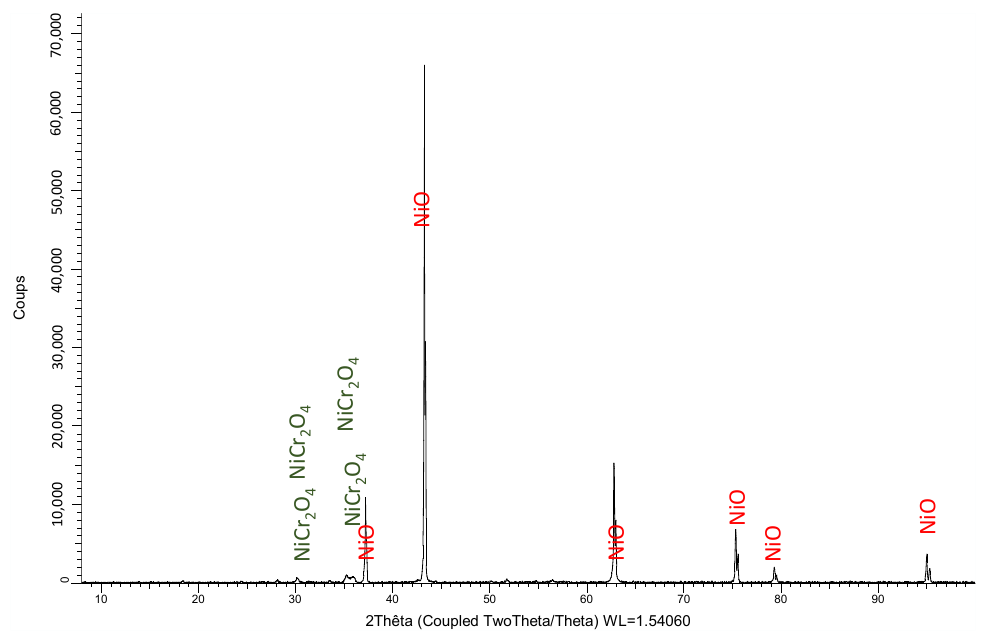
Figure 6. Diffractogram acquired on the oxidized surface of the Ni–25Cr–0.50C–1.9Zr sample.